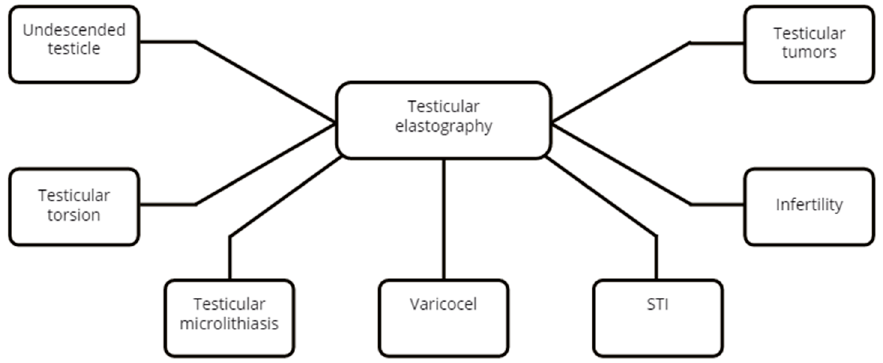
Figure 3. Testicular pathologies assessed by elastography.